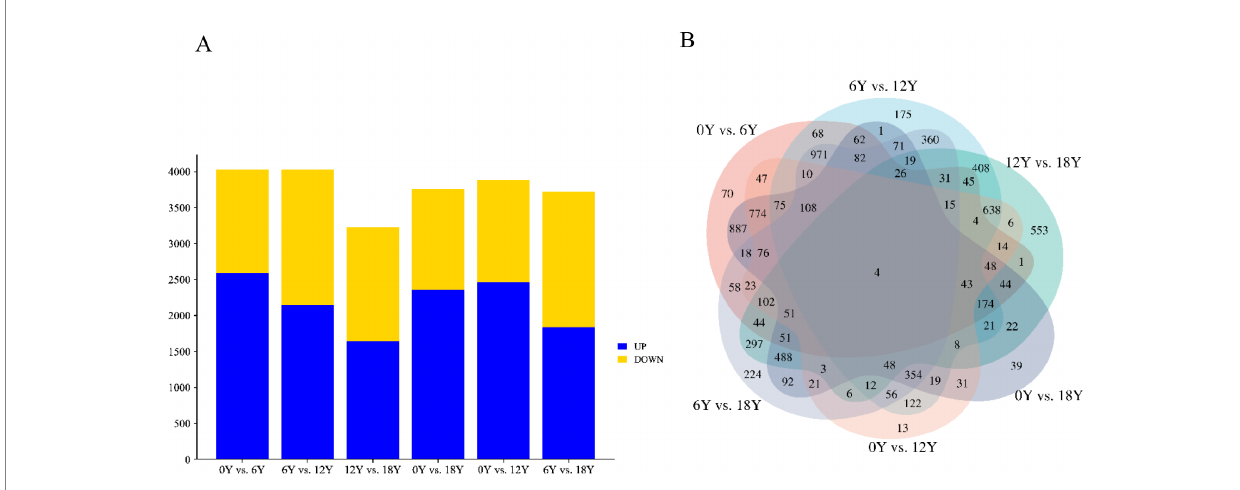
FIGURE 3 Summary of differential expression analysis of annotated circRNAs. (A) Number of DEcircRNAs in different control groups. (B) Wayne diagram of DEcircRNAs in different control